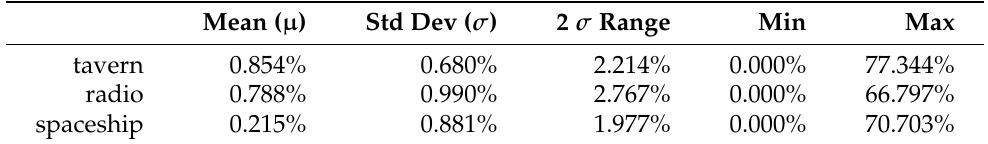
Table 3. Error analysis for